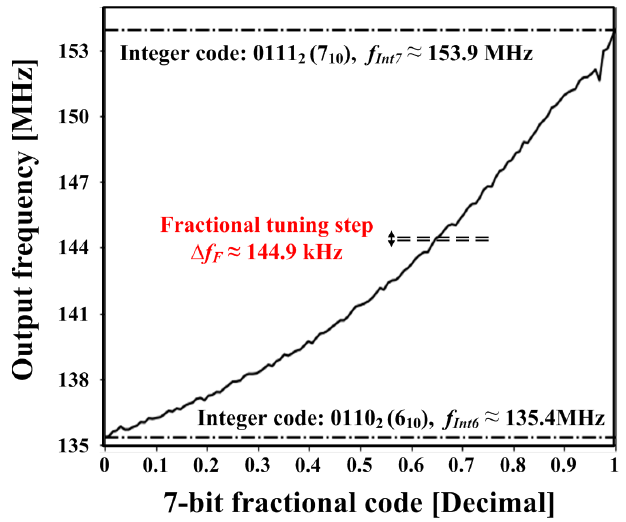
Figure 9. Measured ring-DCO tuning characteristics for fractional code range.